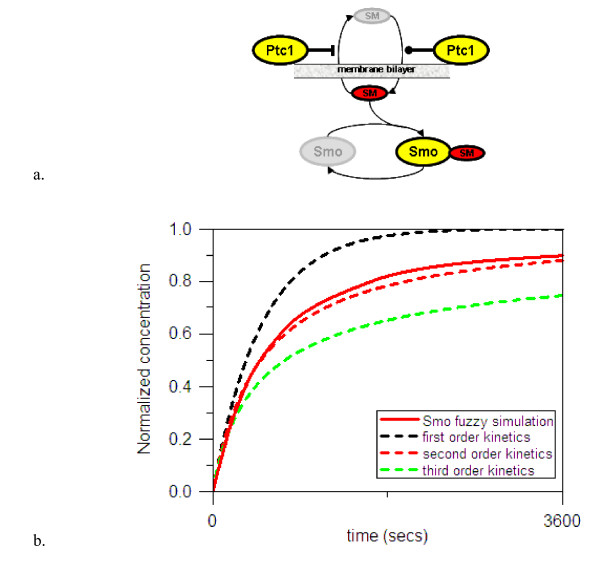
a. Smo is activated when it combines stoichiometrically with a small molecule (sm, red) that changes its conformation. The small molecule must be actively transported across the cell membrane by Ptc1, or is prevented from exiting the cell membrane by Ptc1, which acts catalytically. Active forms are in color, inactive in gray. b. A time series for activated Smo concentration is shown when inactive Smo combines stoichiometrically with a small molecule activator. This is a second order reaction. Analytic solutions for first, second and third order kinetics are also shown. Rules for the model is simulated are described in the text.